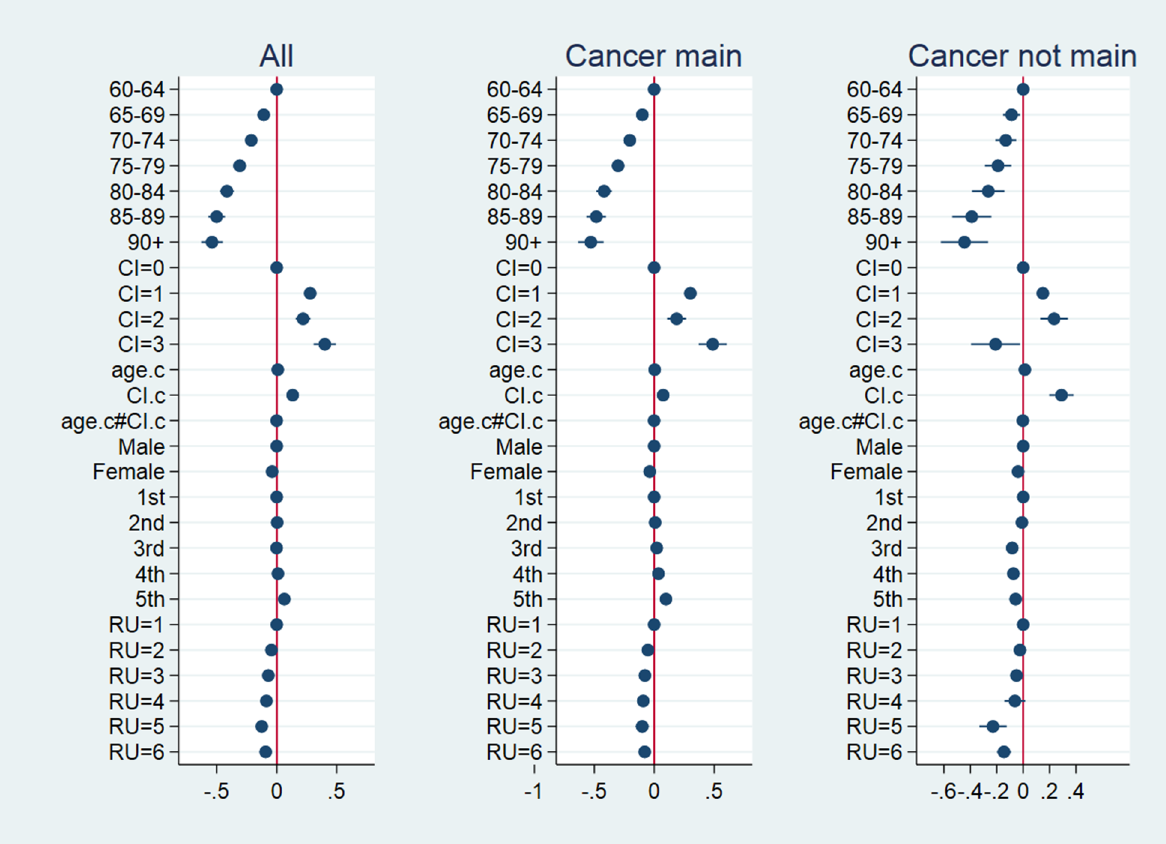
CI: Charlson Comorbidity Index; age.c: Age as a continuous variable; CI.c: Charlson Comorbidity Index as a continuous variable;age.c#CI.c: Interaction between age and Charlson Comorbidity Index (both as continuous variables); 1 st to 5 th : SIMD1 to SIMD 5 (Scottish index of multiple deprivation) in quintiles from most to least deprived areas; RU: Urban-rural